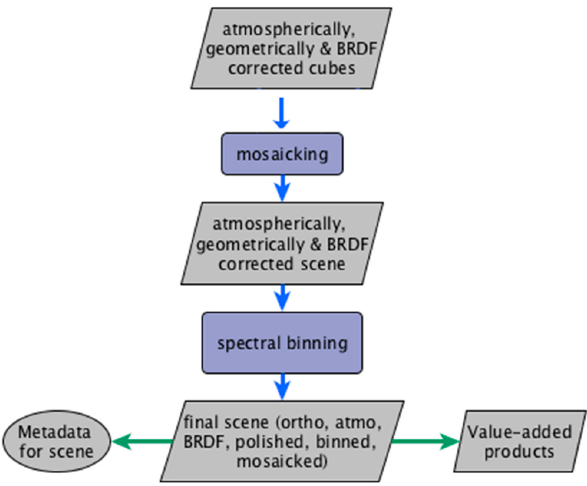
Figure A3. Mosaicking and spectral binning